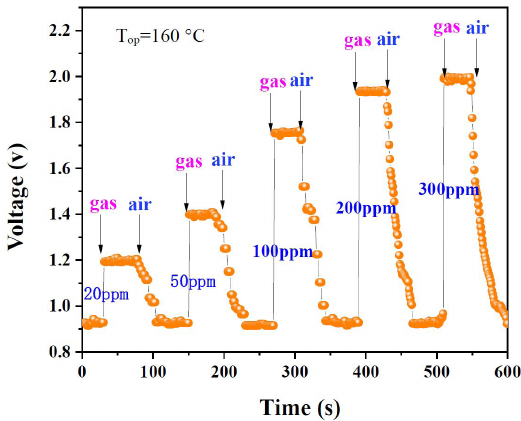
Figure 7. Sensitivity plot of WO concentration.